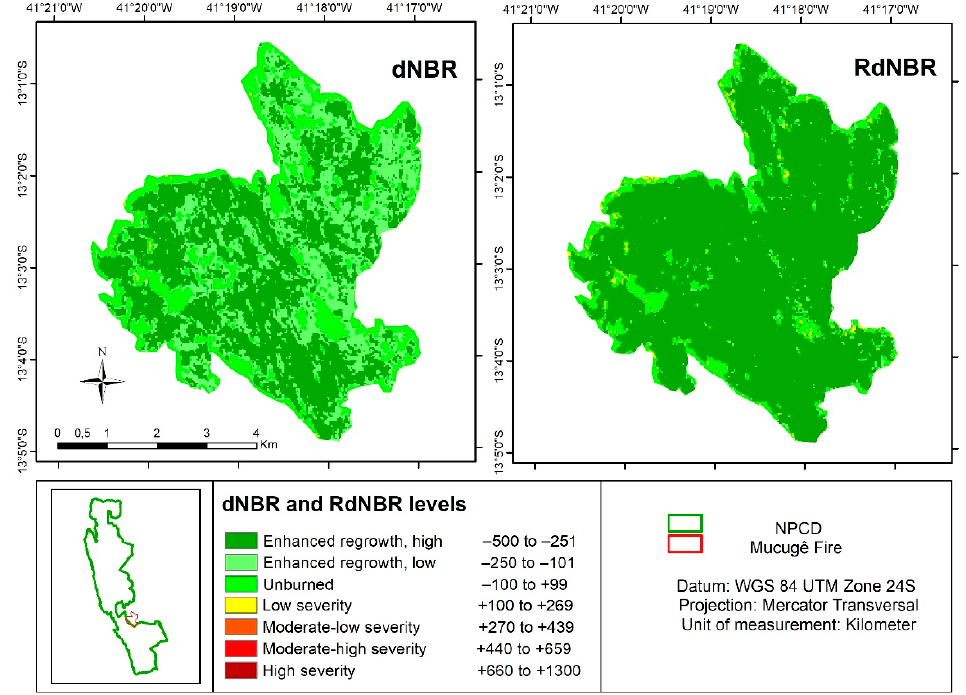
Figure 11. Regrowth following the fire identified by the dNBR and RdNBR indices relating to the fire near Mucugê (classification by Key and Benson [10]).